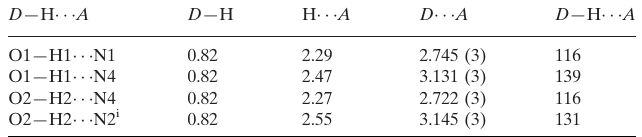
Bruker SMART CCD area-detector diffractometer Absorption correction: multi-scan ( SADABS ; Sheldrick, 2001)